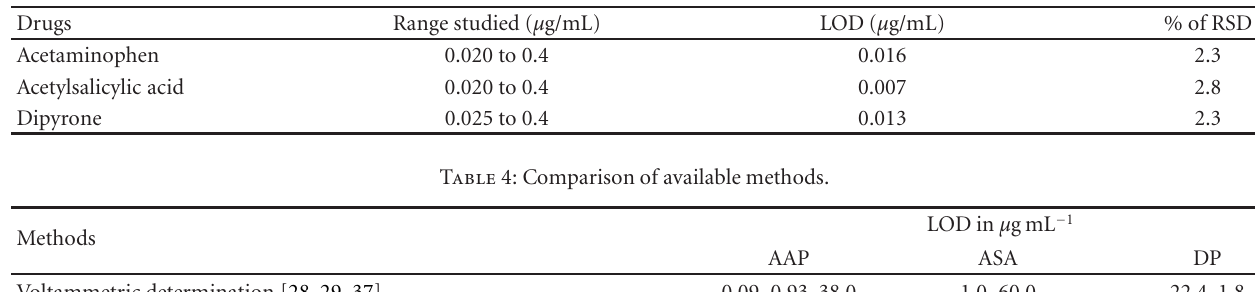
Table 3: SWSV behaviour of analgesic drugs.